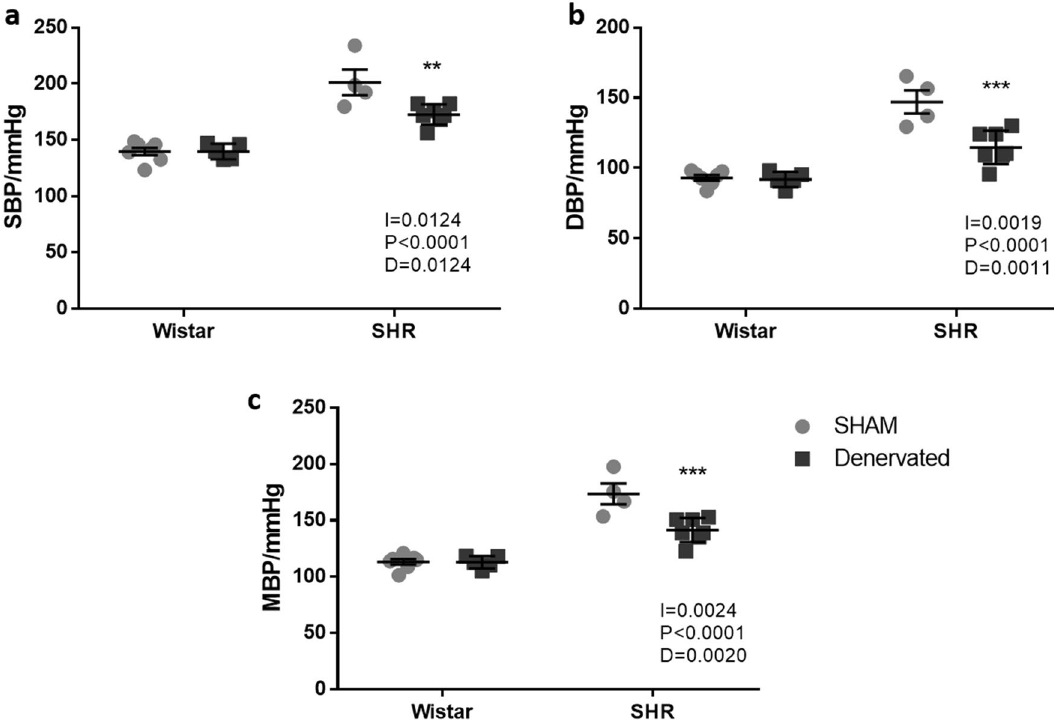
Figure 1. Blood pressure 4 days after intervention. ( a ) Systolic blood pressure (SBP); ( b ) diastolic blood pressure (DBP); ( c ) mean blood pressure (MBP). Data were analyzed by two-way ANOVA followed by Tukey’s post hoc test. Values are mean ± SEM. ANOVA: Interaction factor (I); Blood pressure background factor (P); Denervation factor (D). **p < 0.01; ***p < 0.001 vs. hypertensive sham